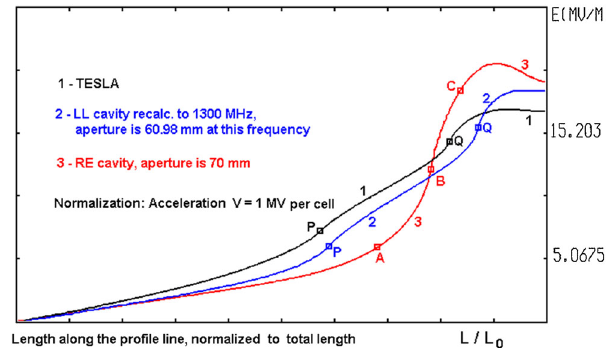
FIG. 4. Electric field on the surface of the cavities from Fig. 3.